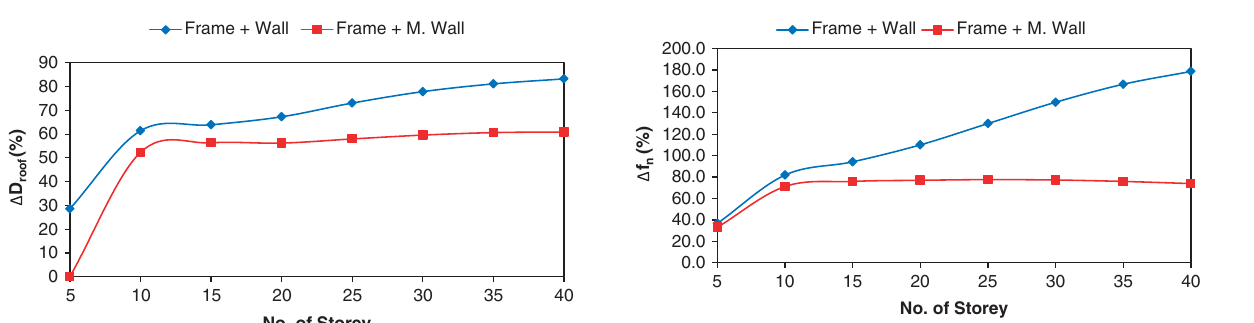
Fig. 8. Increment of roof displacement, Δ D roof , in effect of masonry